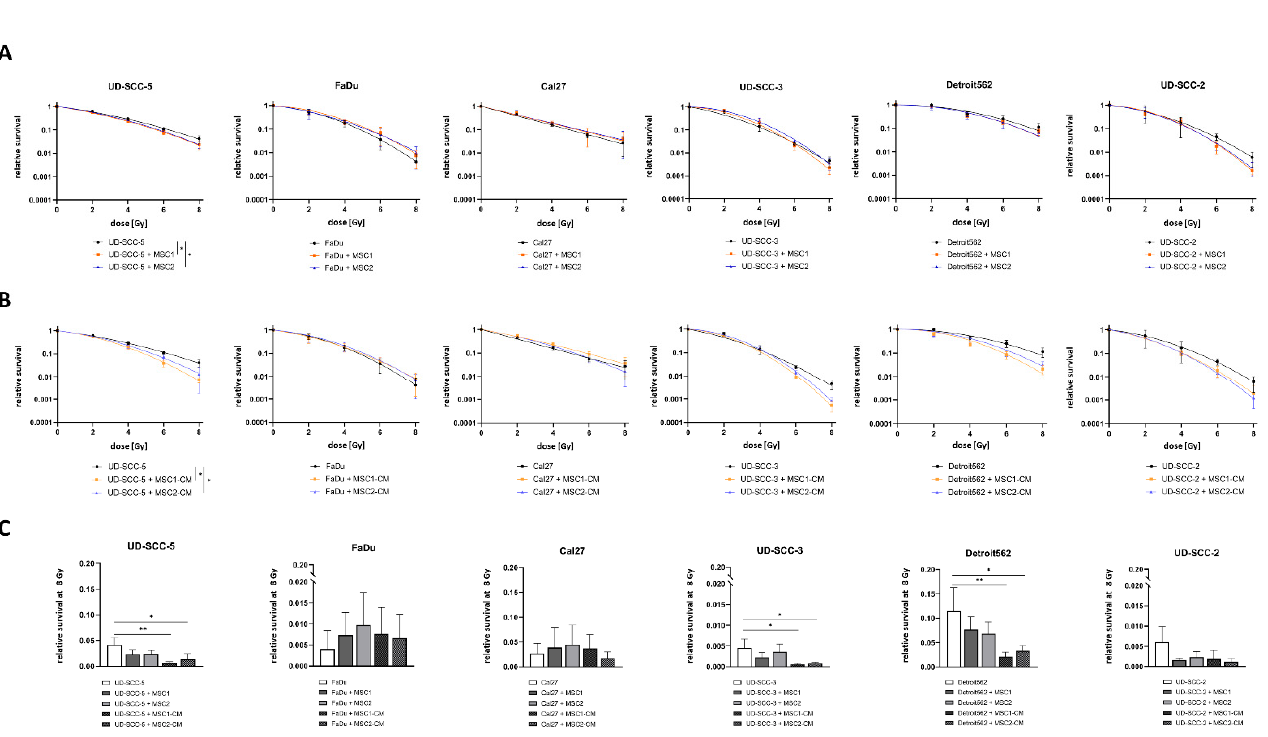
Figure 1. Neither direct nor indirect MSC co-culture increase HNSCCs’ radioresistance. ( A , B ) Clonogenic survival assays of HNSCCs either alone, co-cultured with MSCs ( A ) or co-cultured in MSC-CM ( B ) after irradiation. Clonogenic survival curves were modeled using the linear-quadratic model. * p < 0.05 (paired t -test). ( C ) Relative survival rates at 8 Gy for HNSCC mono-culture, direct HNSCC-MSC co-culture, and indirect (i.e., MSC-CM) HNSCC-MSC co-culture. Mean values with the according standard deviations are shown. Here, each group was compared with the HNSCC mono-culture using a one-way ANOVA with post-hoc Dunnett’s tests. * p < 0.05, ** p < 0.01.